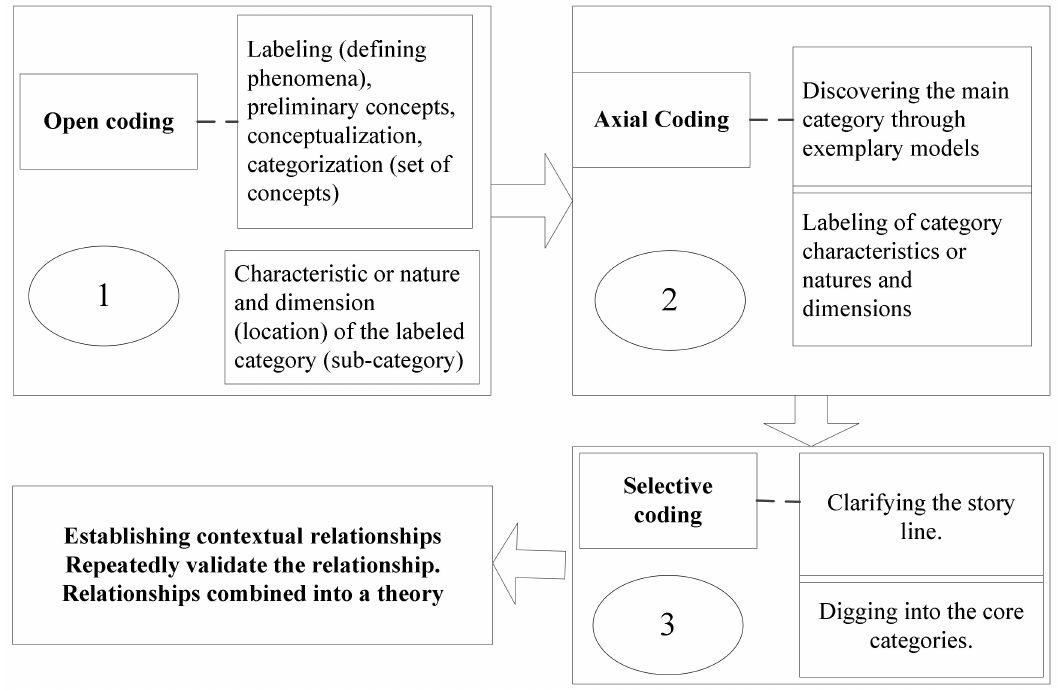
Figure 3. Coding